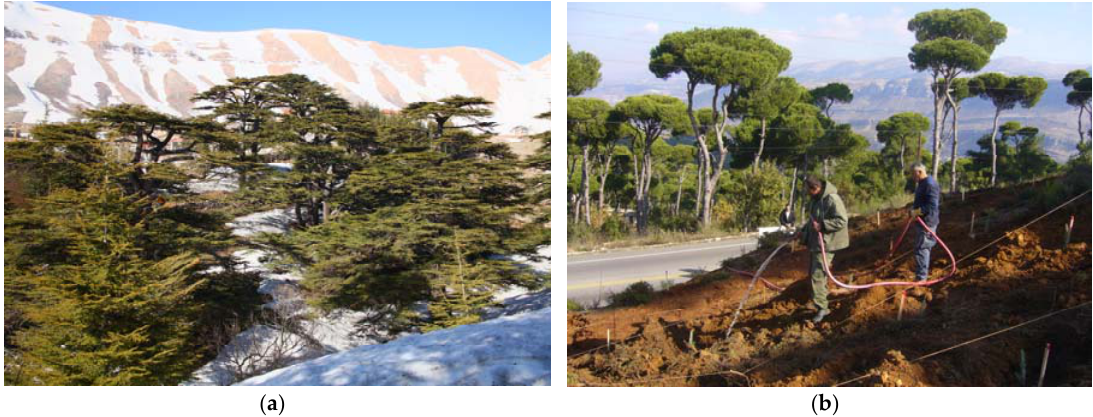
Figure 1. ( a ) One of the remaining old ‐ growth Lebanon cedar groves on the west side of the ridge just below Mount Lebanon; ( b ) Mature stone pines at this study’s Bkassin trial site. Foreground shows conventional irrigation of seedlings in mechanically ‐ prepared soil.